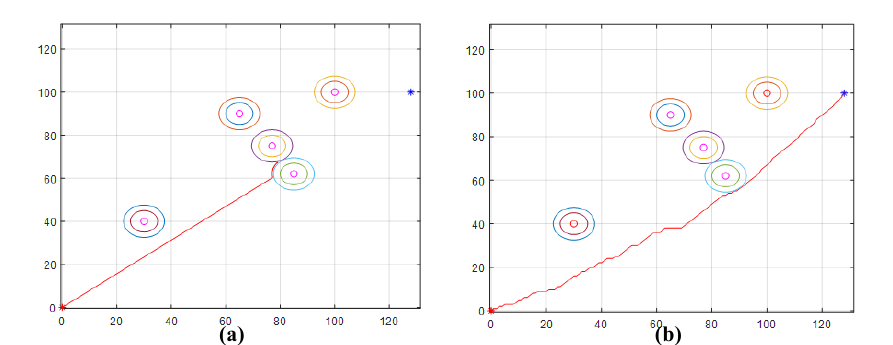
Fig. 8. Scenario 2 initial path and modified algorithm path.